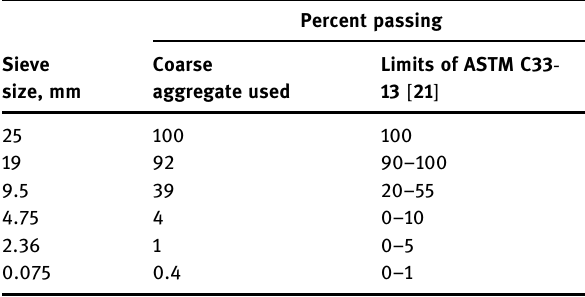
Table 4: Grading of the coarse aggregate used